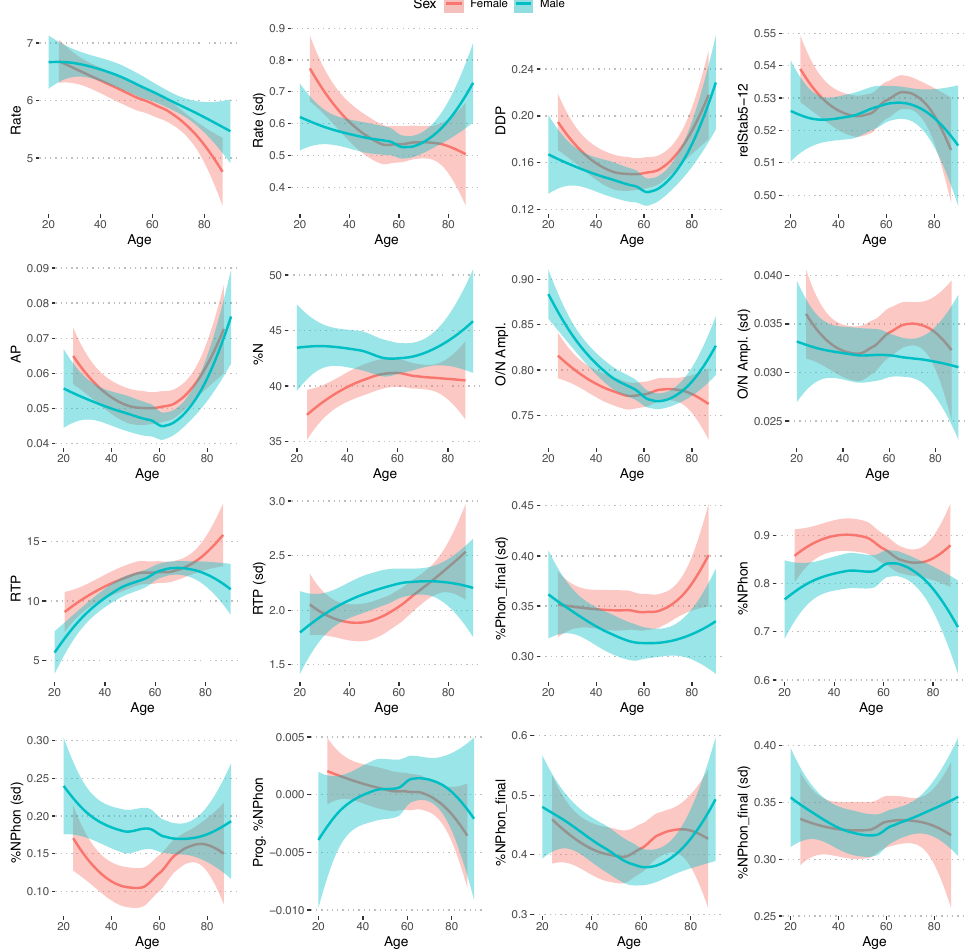
Figure 4. The sex-specific pattern of change with age for identified acoustic measures of DDK sequences. The trend lines were computed as locally smoothed regression lines (LOESS) using a span of 0.75.